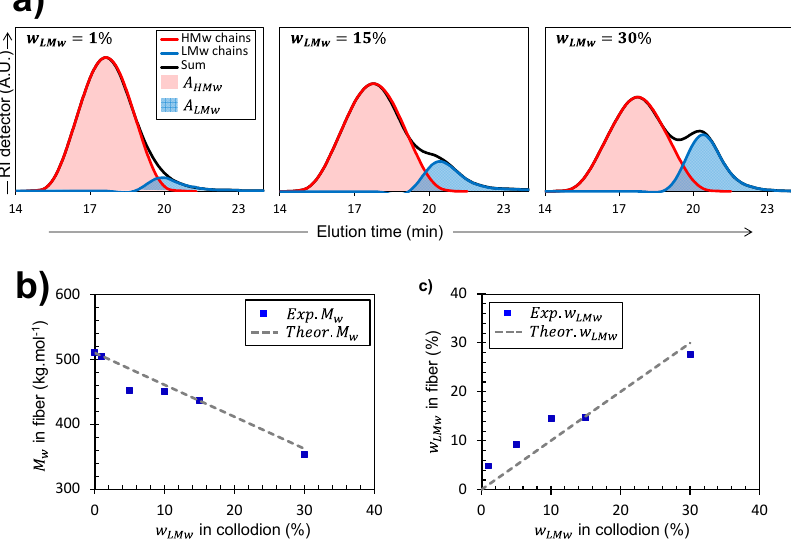
Figure 4. ( a ) SEC/MALLS analyses showing the high- (HMW) and low-molecular weight (LMW) chitosan chains’ distributions obtained in fibers produced from collodions containing different LMW fractions w MLW , namely 1, 15, and 30%. ( b ) Experimental weight-averaged molar masses within the processed fibers Exp . M W (solid squares) produced from collodions with different LMW fractions w MLW . The experimental values are compared with the Theor . M W represented by the dashed line ( c ) Fractions of LMW deduced from the SEC/MALLS measurements after dissolution of fiber samples ( Exp . w LMW ) vs. LMW fraction initially incorporated in the collodion w LMW . The fraction of LMW chitosan evaluated in the fiber from the elution diagrams is close to that of the initial collodion precursor w MLW , evidencing the absence of leakage of LMW chains in the spinning process (dashed line: first bisector).